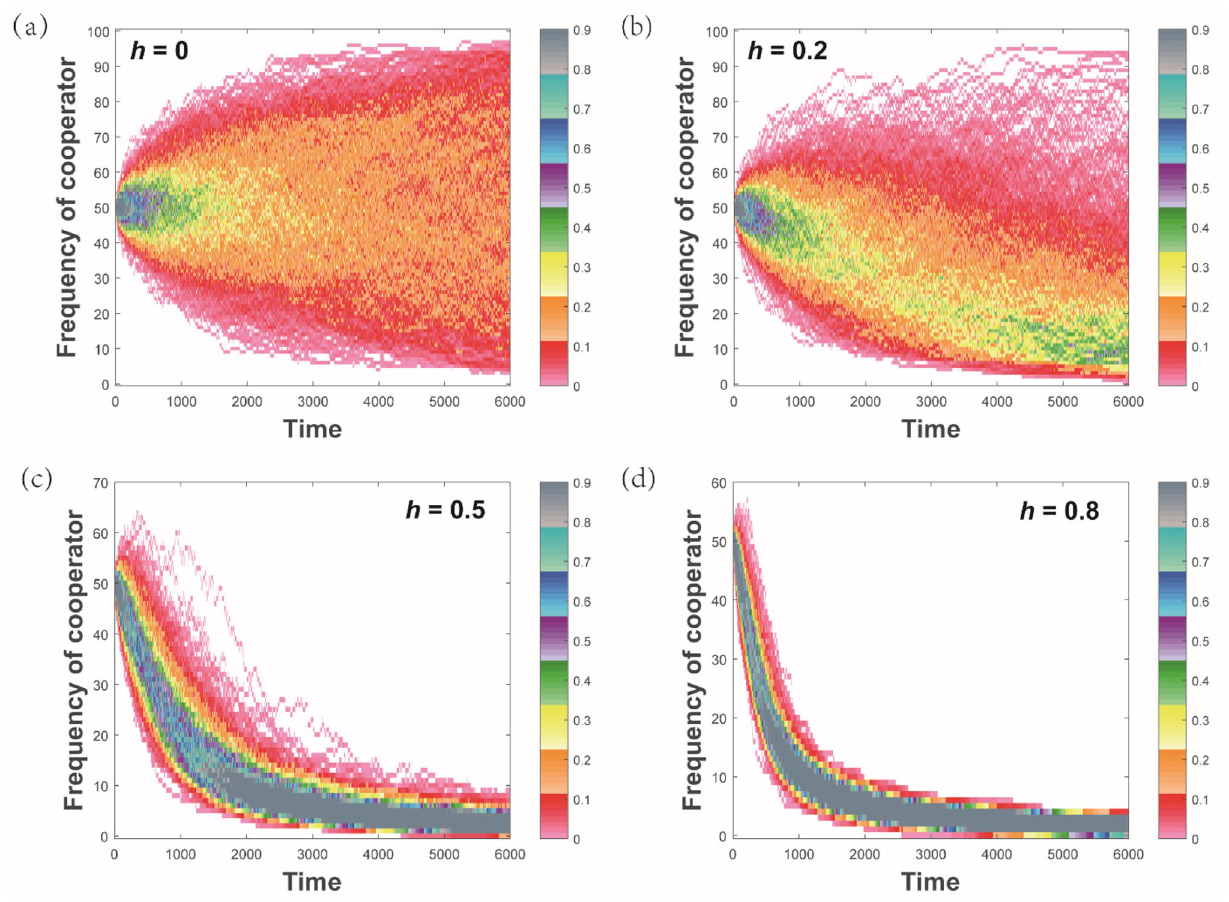
Figure 5. The distributions of the evaluation path probability under different selection pressure in the simulation of evolutionary game. ( a – d ) correspond to different selective pressure, h = 0, 0.2, 0.5, 0.8,